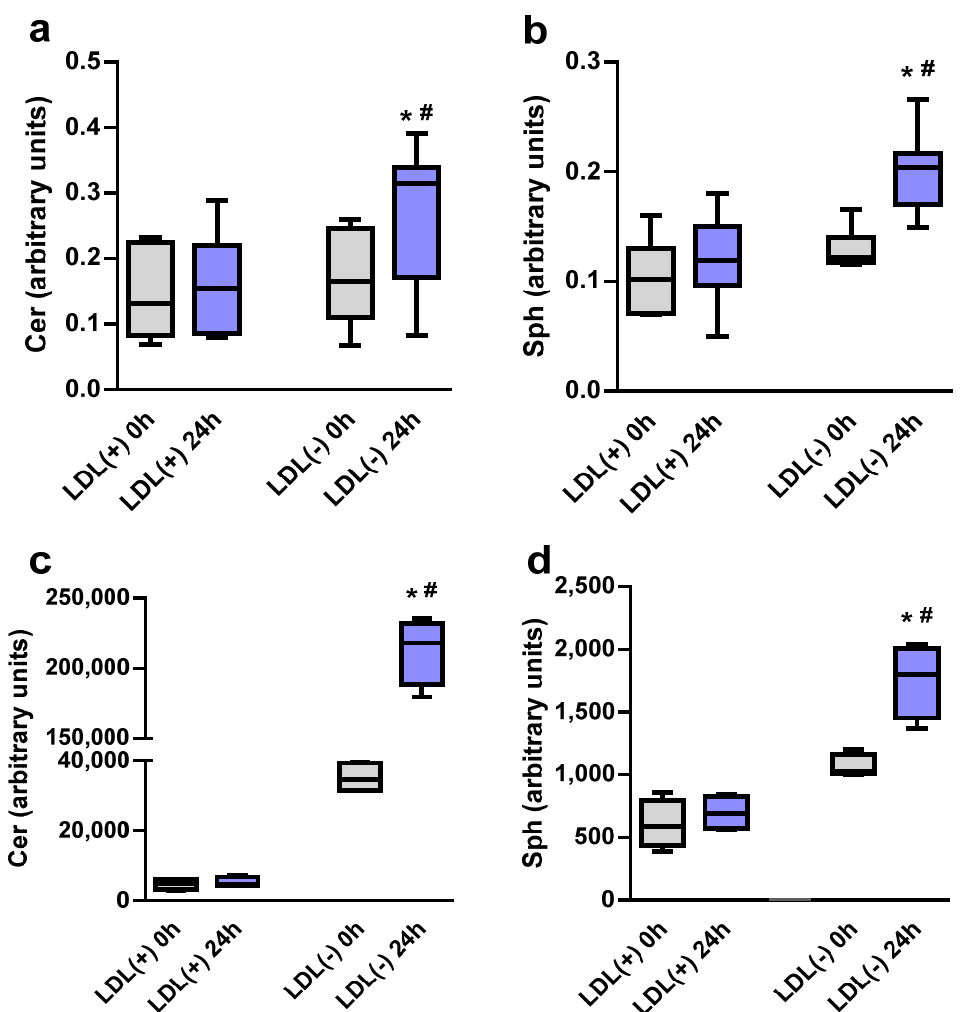
Figure 1. Ceramide (Cer) and sphingosine (Sph) contents in LDL(+) and LDL( − ), basal and after 24 h of incubation at 37 °C. ( a , b ) Data obtained by TLC ( n = 9). ( c , d ) Data obtained by lipidomic analysis ( n = 4). * p < 0.05 versus LDL( − ) at 0 h; # p < 0.05 versus LDL(+) at 24 h.